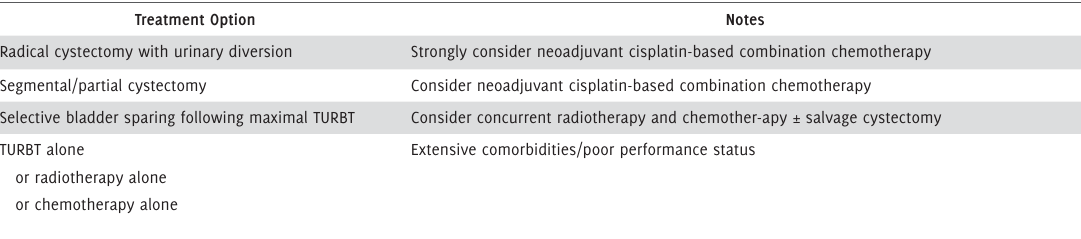
Table 2. Summary of Primary Care Protocols for cT2